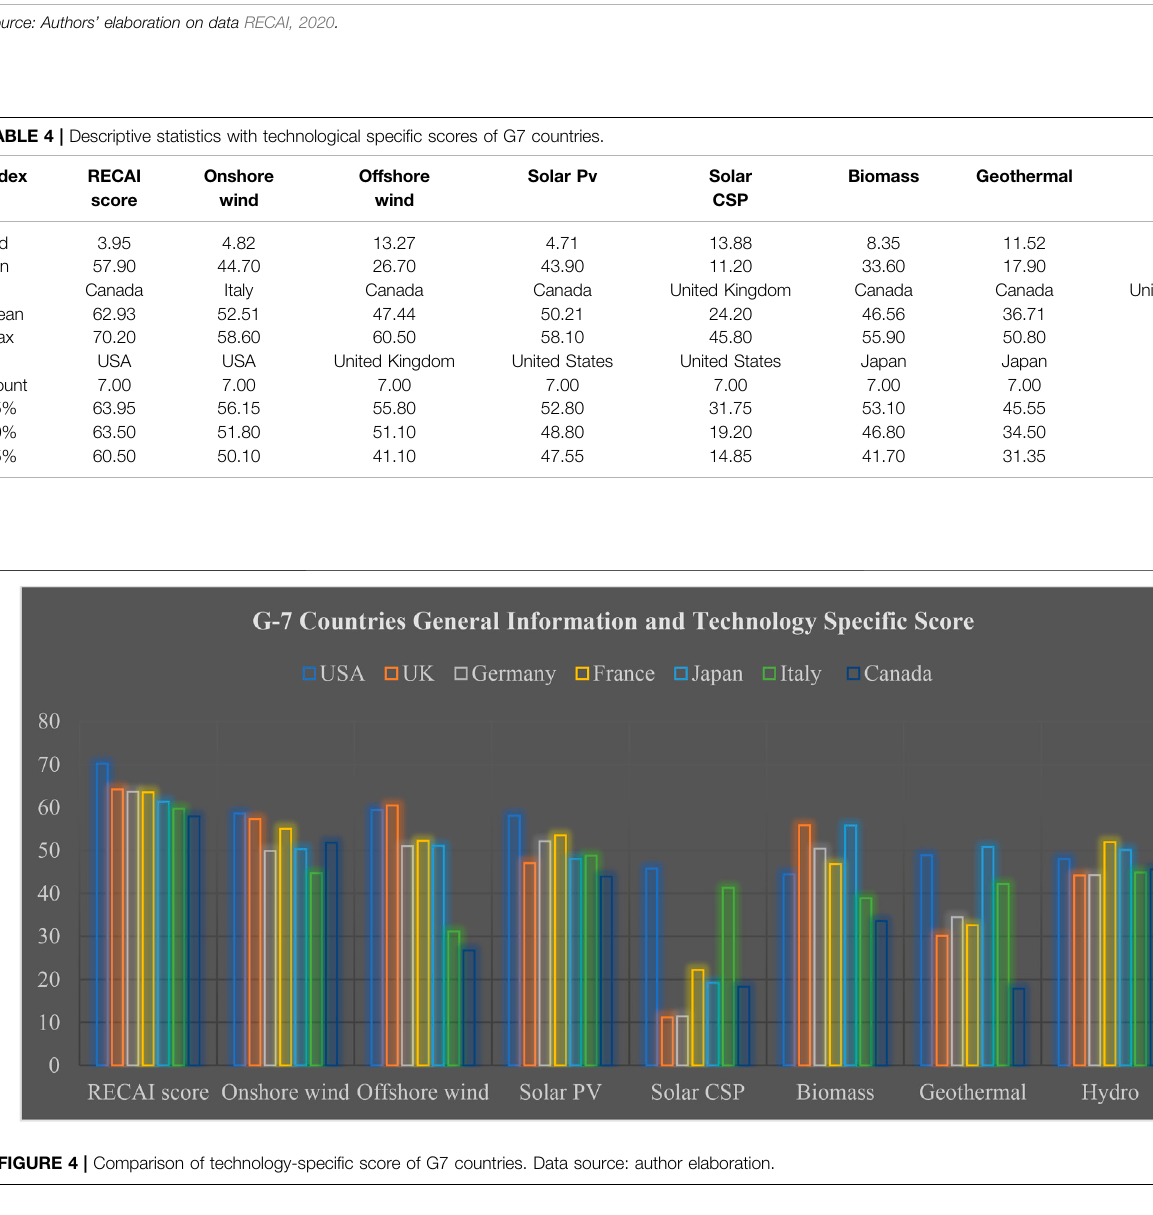
Frontiers in Environmental Science |